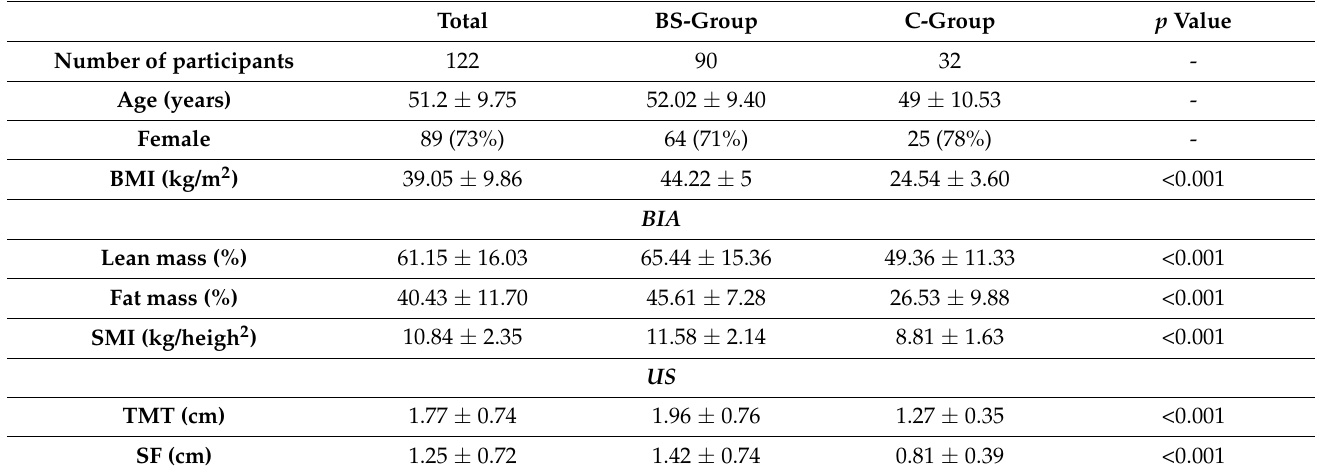
Table 1. Basal characteristics of participants and muscle and fat tissues measurements using BIA and US.